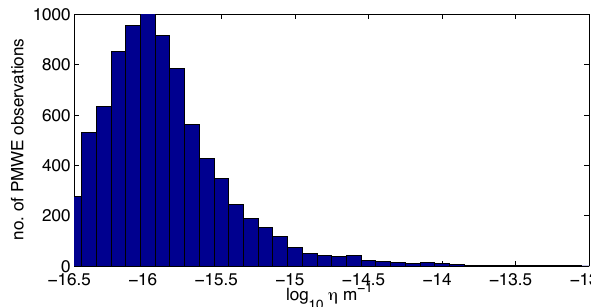
Figure 3. Distribution of PMWE volume